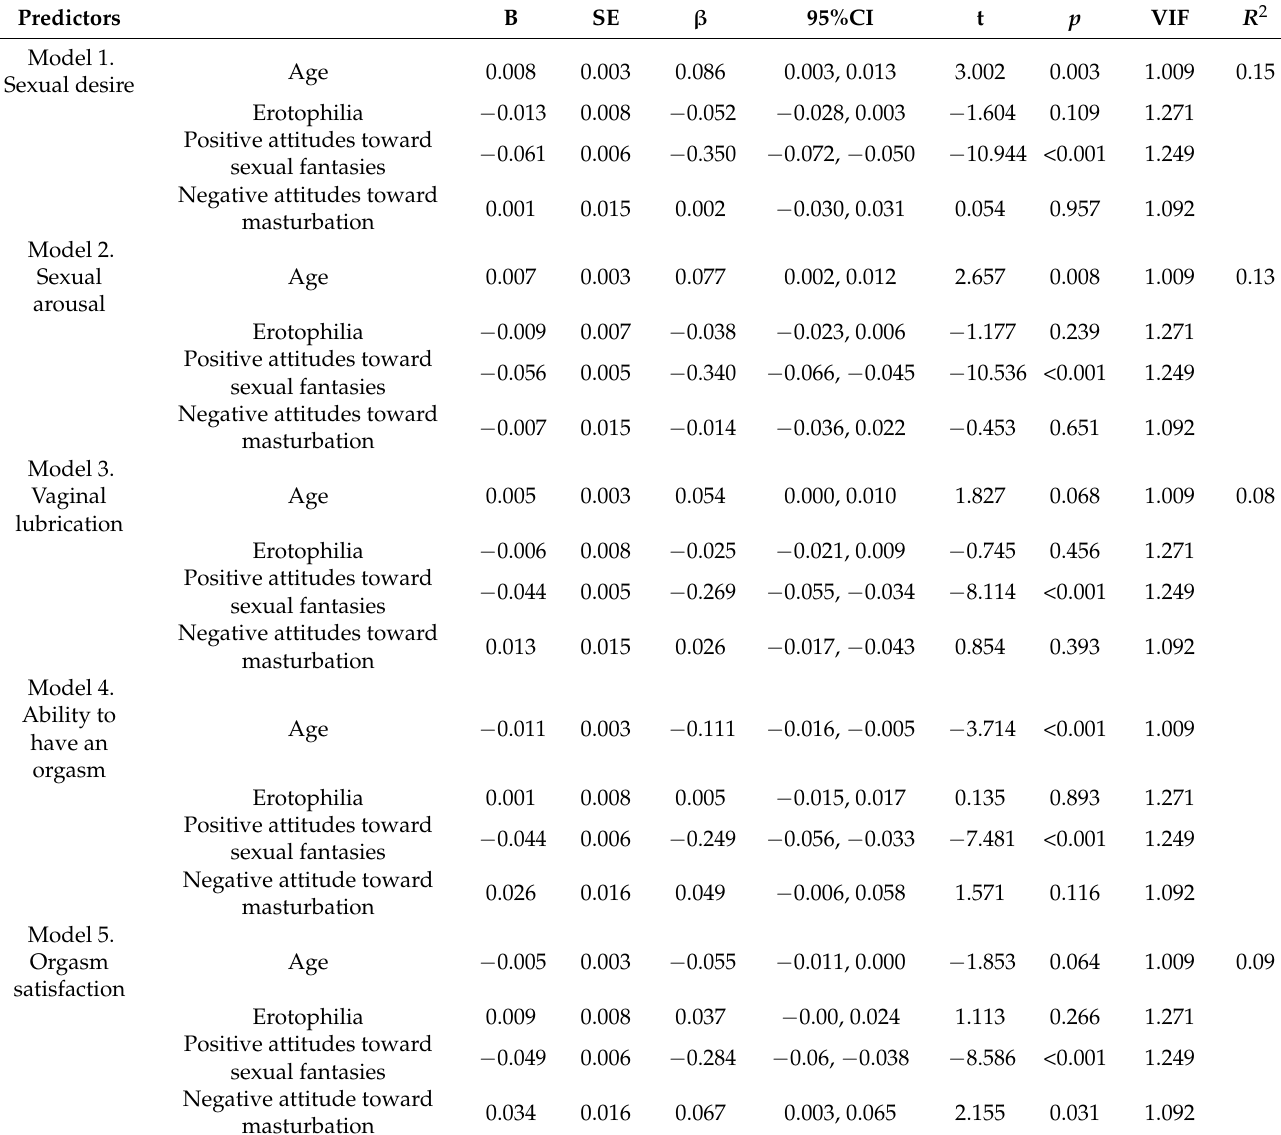
Table 3. Hierarchical regression for sexual function in